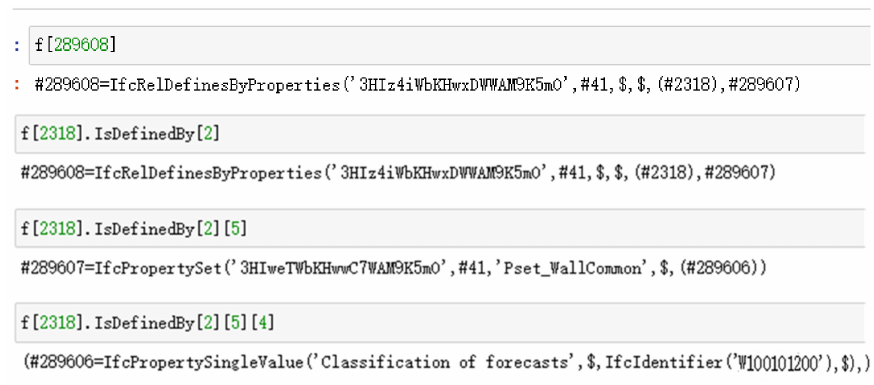
Figure 10. IFC Extension